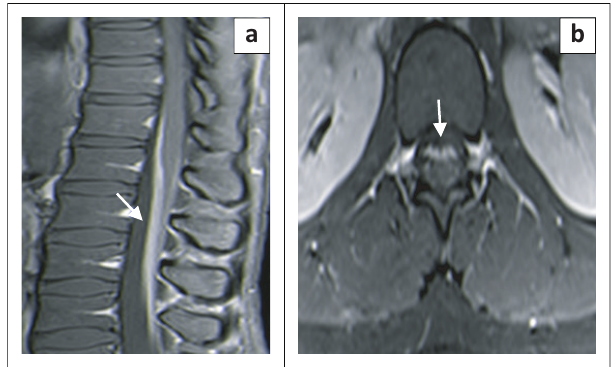
FIGURE 1: (a) Post-gadolinium sagittal and (b) axial lumbosacral spine images showing ventral root enhancement (arrows).